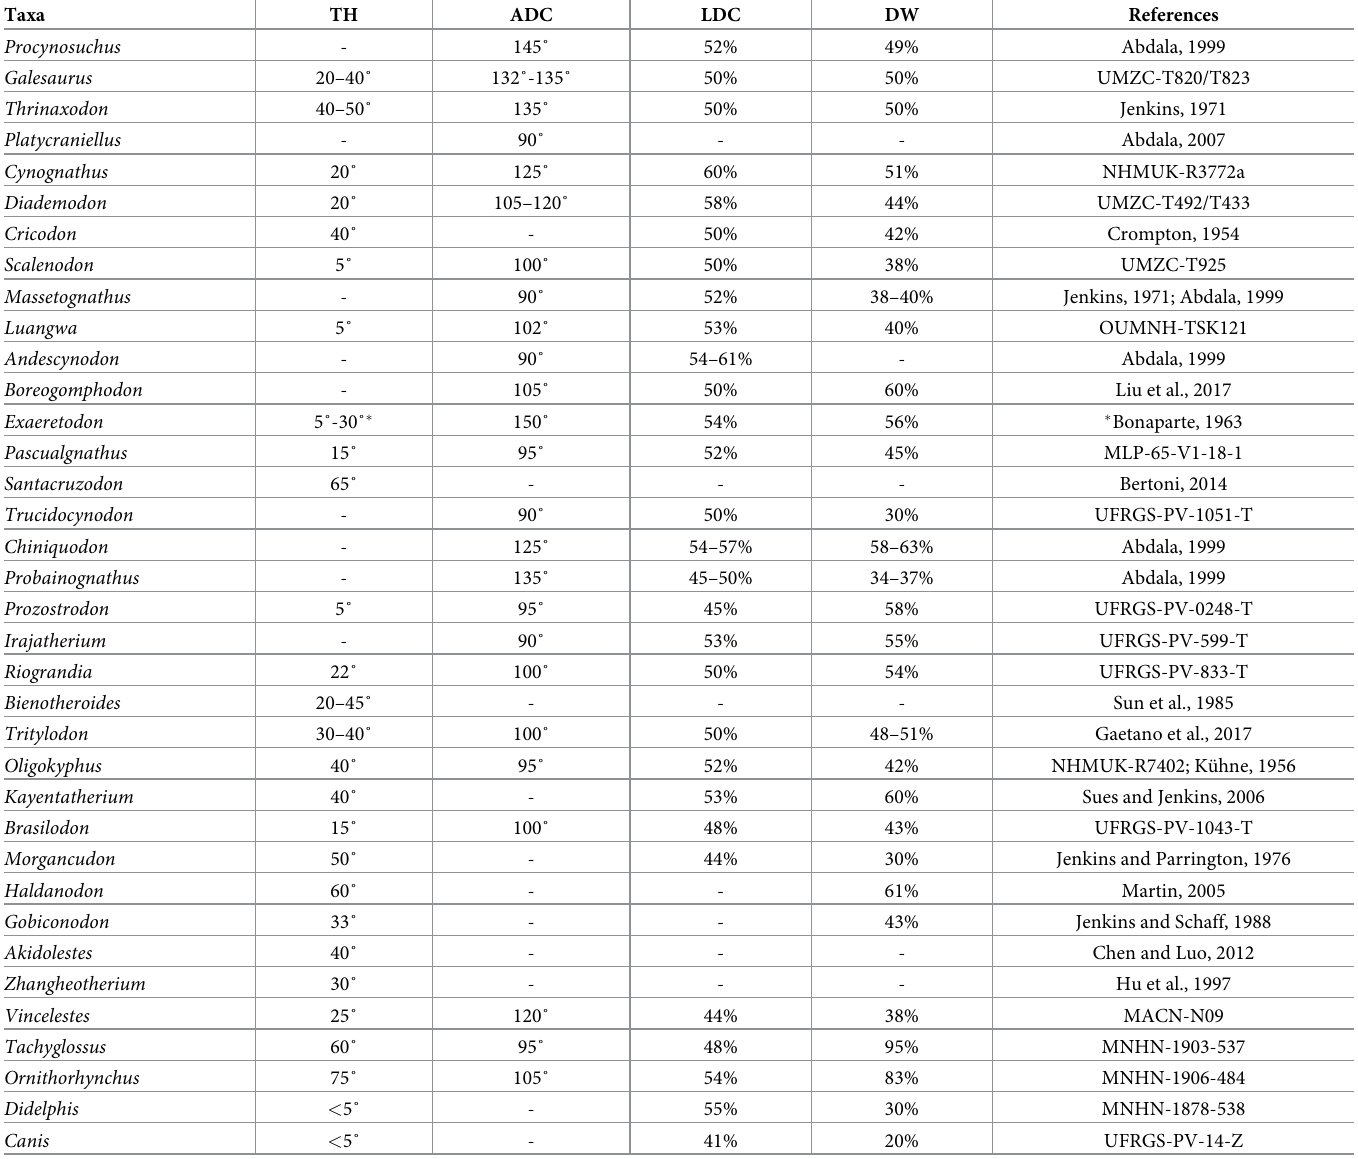
Table 2. Angles and indices of non-mammaliaform cynodonts. TH , torsion of humeral shaft; ADC , angle of deltopectoral crest; LDC , length ratio of deltopectoral crest (Length of deltopectoral crest / Humeral length � 100); DW , width ratio of distal end (Distal end width / Humeral length). The angle TH was measured between the trans- versal axes of the proximal end (the axis “Lesser Tuberosity—Medial margin of the humeral head”) and the distal end (the axis “Ectepicondyle-Entepicondyle”), based on the photography of the humerus in proximal view. The angle ADC was measured between the deltopectoral crest and the transversal axis of the proximal end, based on the photography of the humerus in proximal view. The distal end width was measured between the two epicondyles, based on the photography of the humerus in anterior